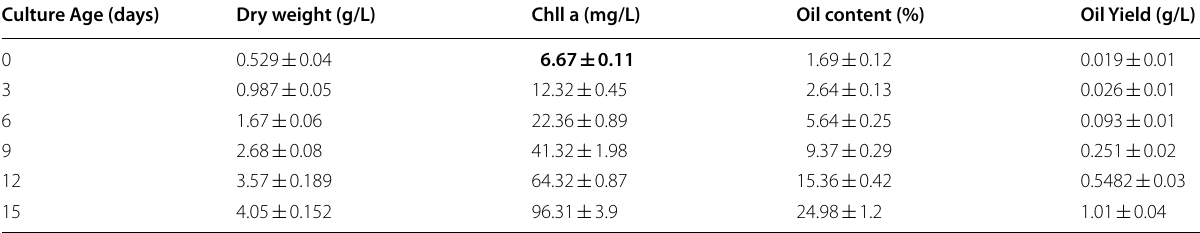
Table 3 Dry weight,Chll a, Oil content and Oil yield of Pseudochlorella pringsheimii grown in photobioreactor (2000 L) under nitrogen, and Phosphours deficient and high concentration of Iron and corbon